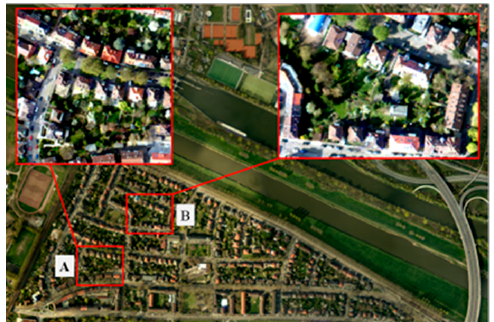
Figure 7. The labeling of experiment area A and B. Figures 8 and 9 show the original feature images for the two data sets, respectively.